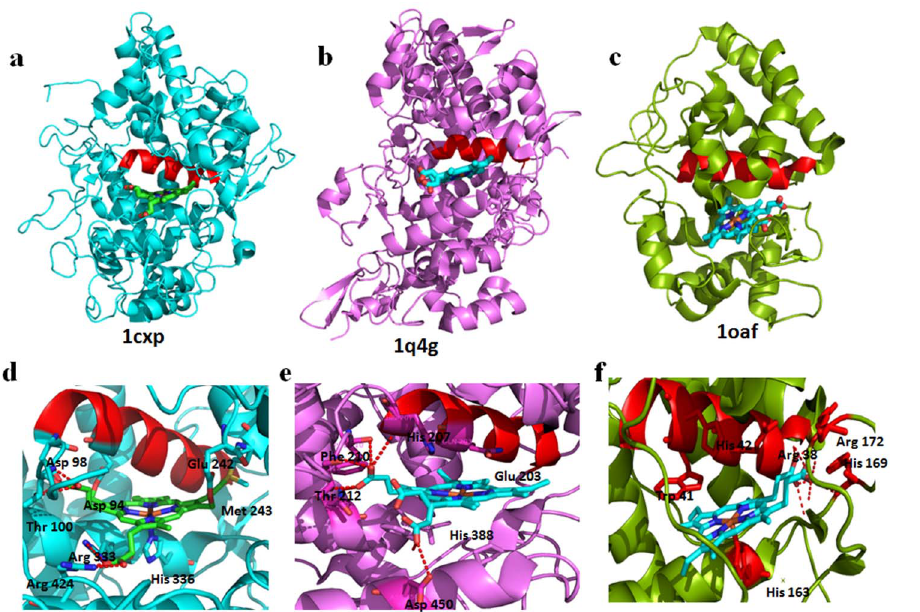
Figure 4. Representative structures of mammalian ((a) MPO (b) PGHS) and (c) non-mammalian peroxidases (1gwu). Both MPO and PGHS are outliers belonging to the mammalian myeloperoxidase family (d)–(f).The peroxidase active site residues and interaction with Heme is shown. In all the cases, the proximal His (H336, H388 and H163) is involved in coordination. Helix H2 and Helix B interact with heme group and are highlighted in red color in all the three structures.